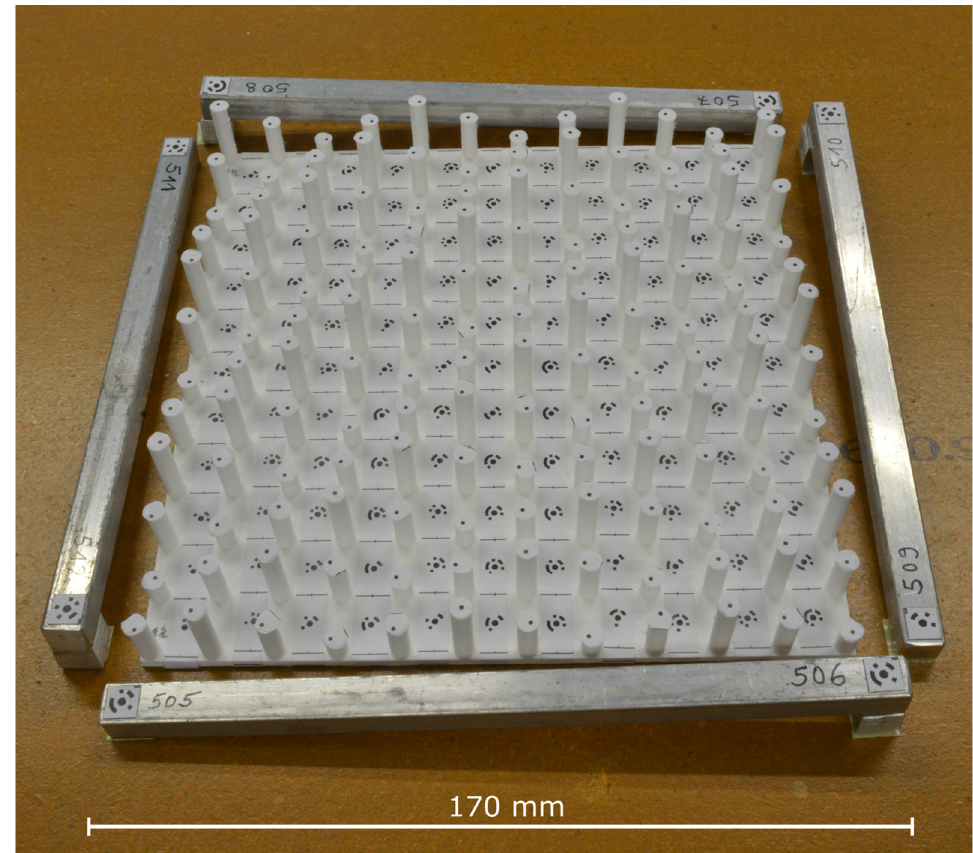
Figure 7. Custom-built 3D calibration